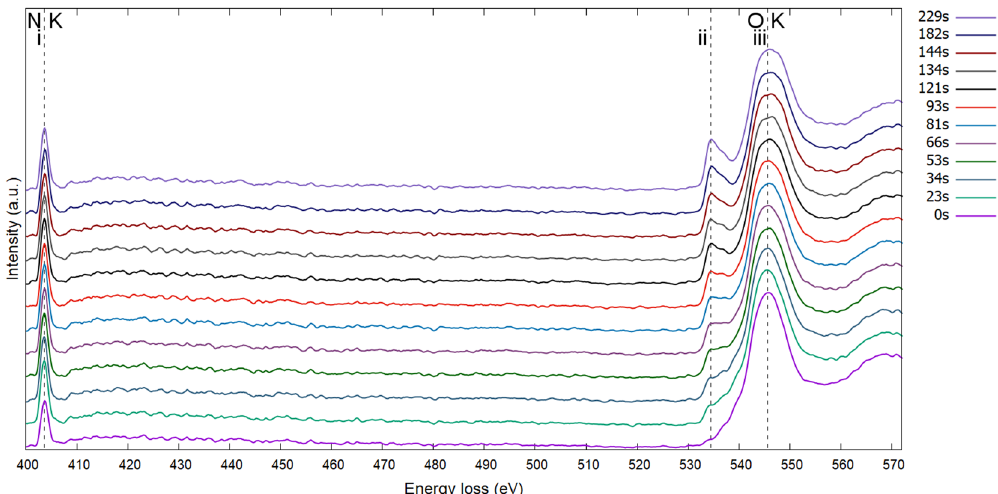
Fig. 7 Ni – Fe LDH core loss EELS time series of the nitrogen and oxygen K edge analysed at 80 kV while the sample is cooled to − 180 °C. The time of the EEL spectra accounts for the total irradiation time of the sampled region at acquisition from 0 to 229